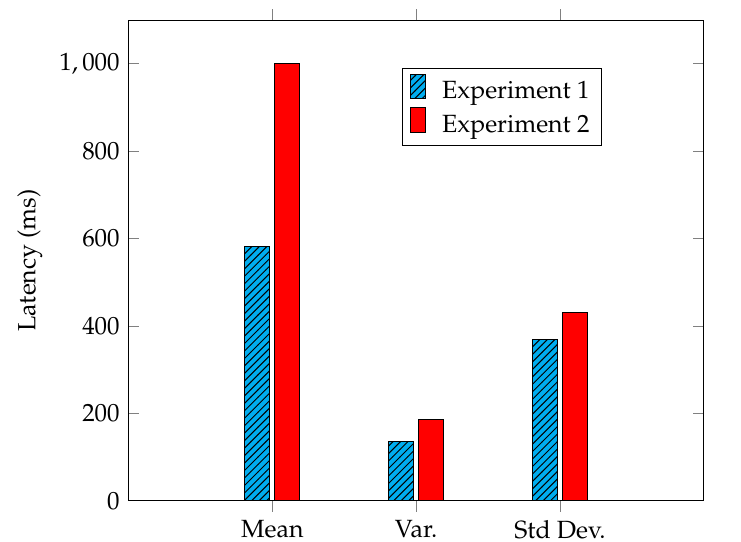
Figure 7. Experiment 1 and 2—Latency statistics.